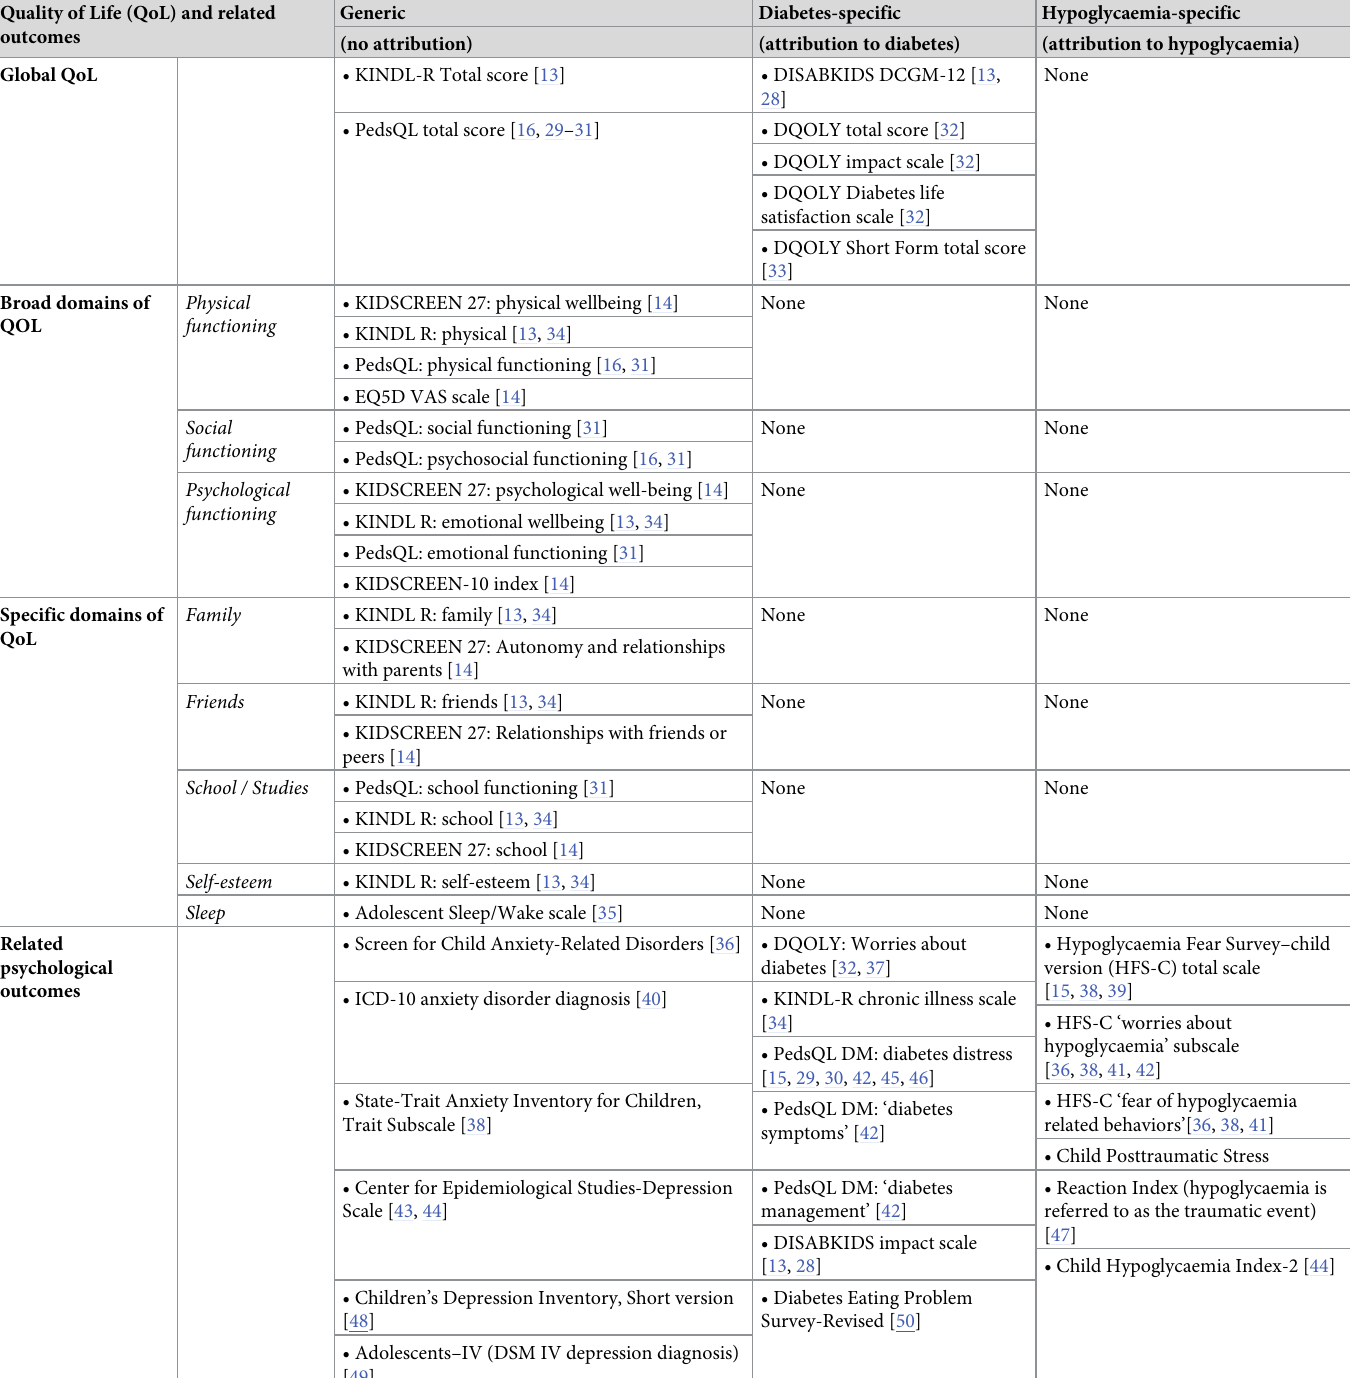
Table 1. Overview of quality of life and related outcome measures in the included studies, by breadth and attribution. Quality of Life (QoL) and related